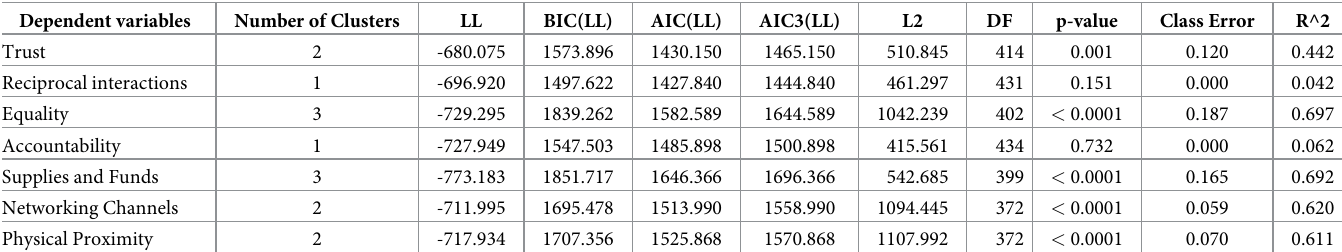
Table 3. Latent class analysis model summary on seven collaboration prerequisites. Dependent